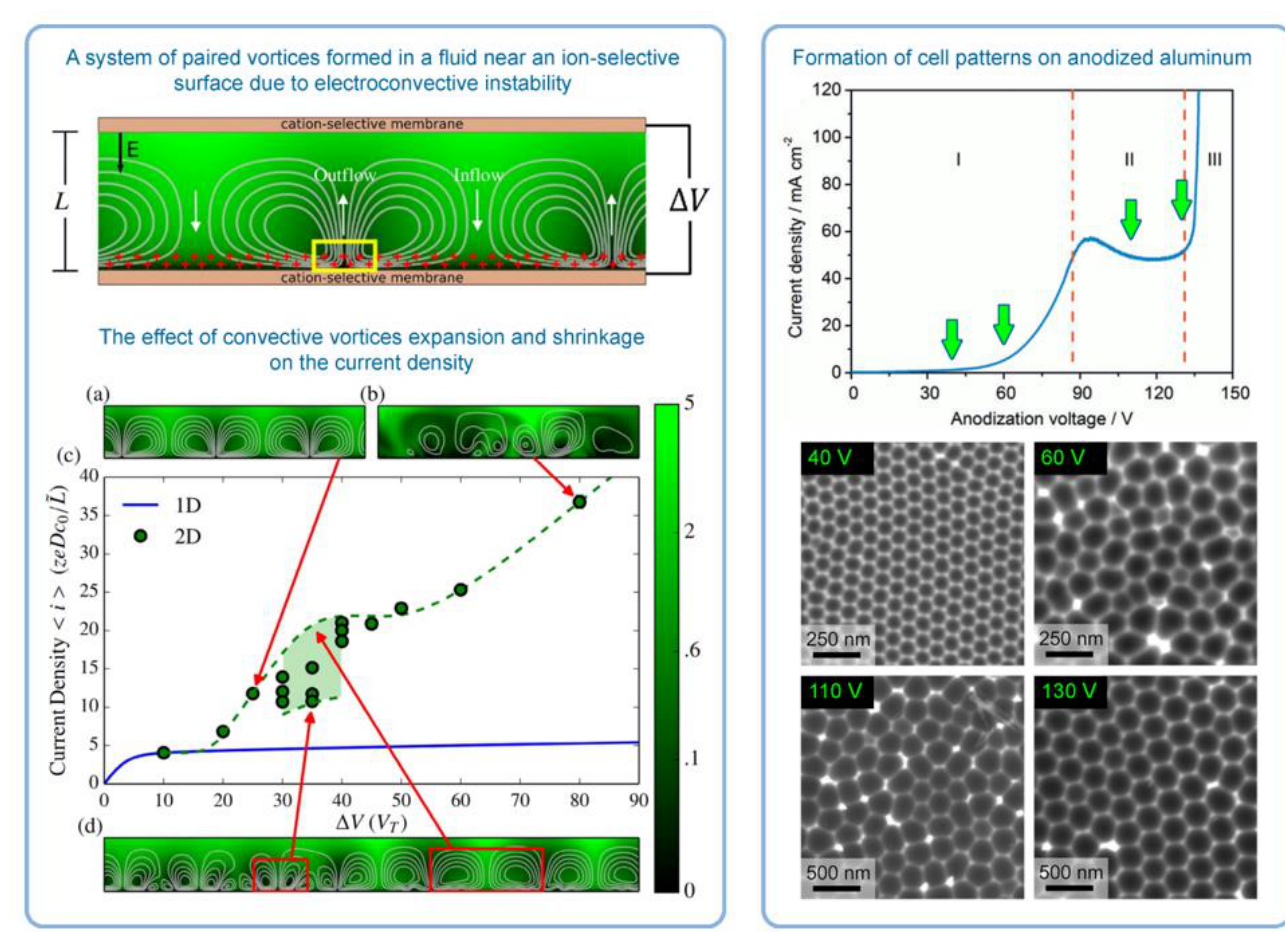
Figure 28. j – ∆ U curves and visualizations of cellular structures displaying similarities in morphology and behavior between different types of self-ordered electroconvective systems. Left: paired cyclic currents emerging in an aqueous electrolyte solution between two cation-selective surfaces when a certain critical voltage is applied (in this case ∆ U ≥ 19 V); ∆ U = 25 V corresponds to a stable regime with equal-sized vortices ( a ), ∆ U ≈ 35 V corresponds to the beginning of chaotic mode where multiple vortex sizes coexist (shown by red frames in ( d )), the plateau region between ∆ U ≈ 35 V and ∆ U ≈ 50 V in the j – ∆ U curve (the green dashed line in ( c )) is a distinctive feature of such chaotic regime. Right: a j – ∆ U curve and SEM micrographs obtained upon Al anodizing in 0.3 M H 2 C 2 O 4 solution (light green arrows show some selected voltages at which potentiostatic anodizing tests were performed); as follows from electron microscopy data, ∆ U = 40 V corresponds to the self-ordering regime where uniform ring-like vortices assist the etching of a regular pattern (“mild anodizing”, MA); the system enters a disordered regime at ∆ U ≈ 60 V, which further extends over the plateau region at 90–130 V (see the micrograph of a sample obtained at 110 V); electroconvection becomes more regularized and forms a new properly sized pattern at ∆ U = 130 V (“hard anodizing” regime, HA); a slightly increased noise level on the j – ∆ U curve at intermediate voltages ( ≈ 100–130 V) is due to the enhanced turbulence of chaotic electroconvection (increased randomness of ionic flows causes observable electric current fluctuations). Adapted with permissions from [46] and [143]. Copyright 2016 Nature and 2017